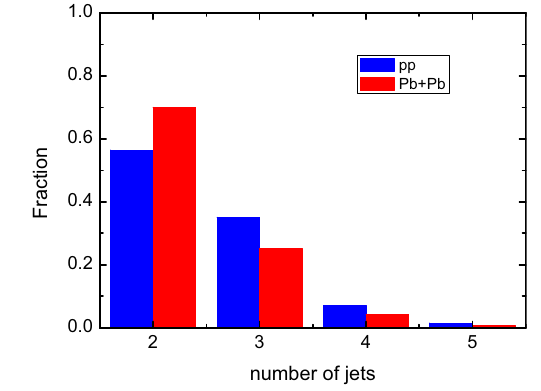
Fig. 7 The production proportion of n jet = 2 events and n jet ≥ 3 events in p+p and Pb+Pb collisions at